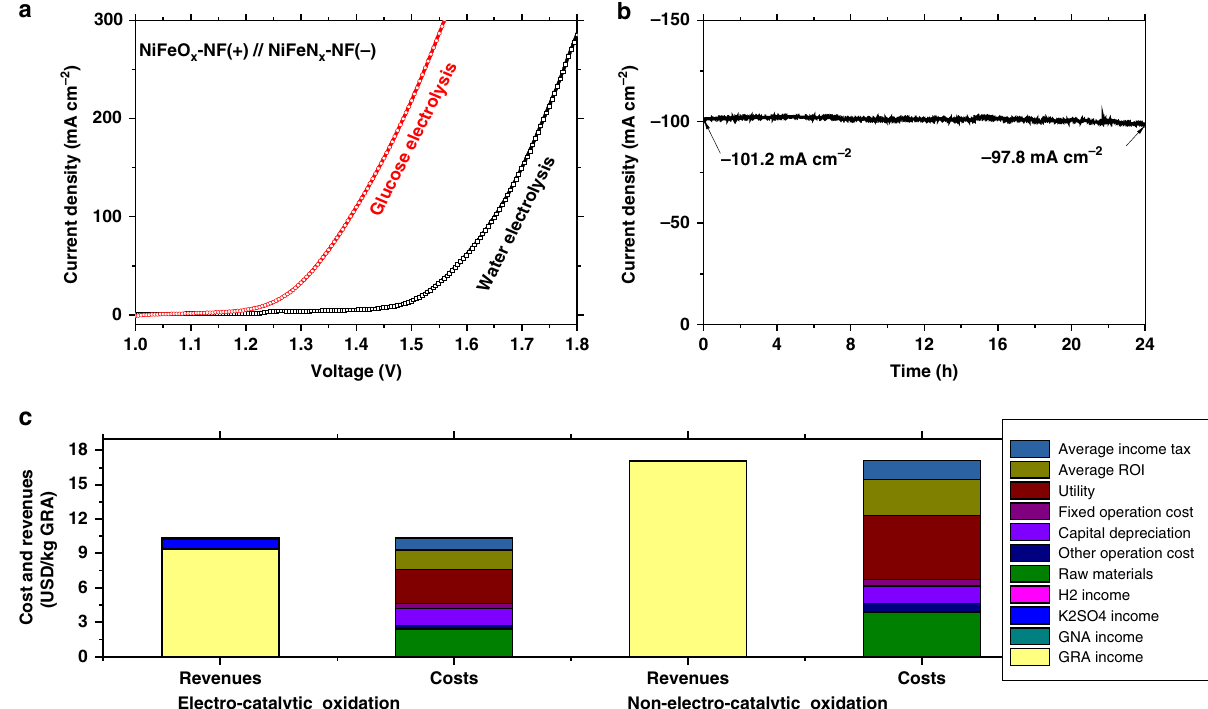
Fig. 8 Process evaluation of the glucose electrochemical oxidation. a Comparison of glucose electrolysis and water electrolysis with the same anodic NiFeO x -NF and cathodic NiFeN x -NF catalysts (scan rate: 5 mV s − 1 , glucose concentration: 100 mM, 1 M KOH). b Long-term stability of the glucose electrolysis at a cell voltage of 1.4 V. c Comparison of the revenues and costs for electrocatalytic glucose oxidation and nonelectrocatalytic oxidation processes (HNO 3 oxidation) for GRA production (1000 tons GRA per